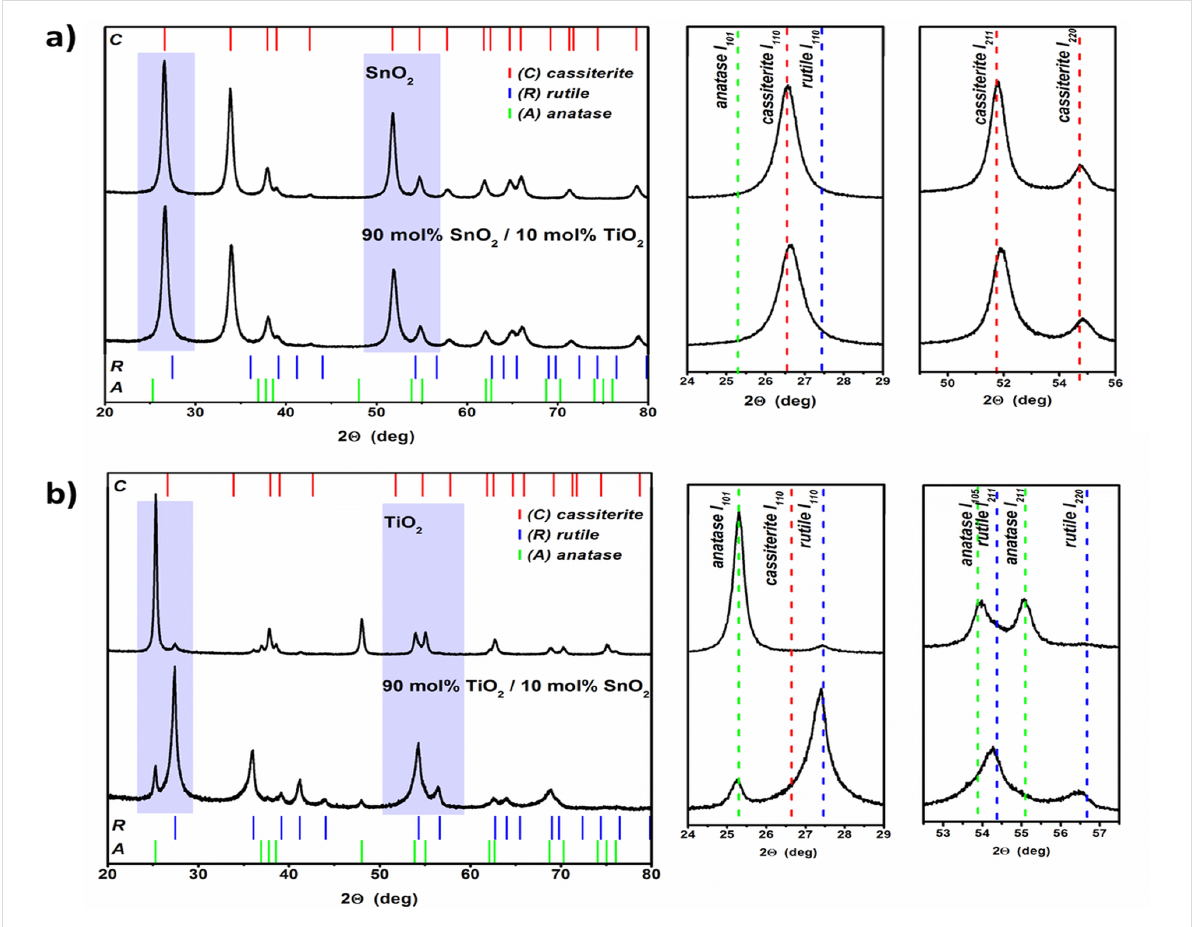
Figure 2: Comparison between XRD patterns of a) SnO 2 and 90 mol % SnO 2 /10 mol % TiO 2 ; b) TiO 2 and 90 mol % TiO 2 /10 mol % SnO 2 nanopowders.